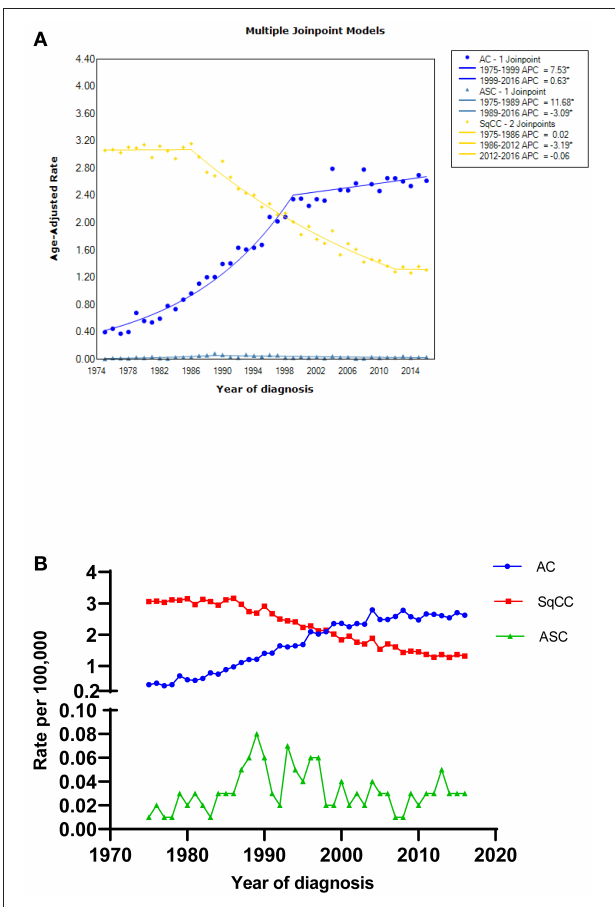
FIGURE 1 | The age-adjusted incidence of esophageal AC, SqCC, and ASC patients between 1975 and 2016 from the SEER database. (A) Figure drawn by the Joinpoint software; (B) Figure drawn by the GraphPad Prism 6 software; * indicated that the APC is significantly different from zero at the alpha = 0.05 level. AC, adenocarcinoma; SqCC, squamous cell carcinoma; ASC, adenosquamous carcinoma; APC, annual percent change.